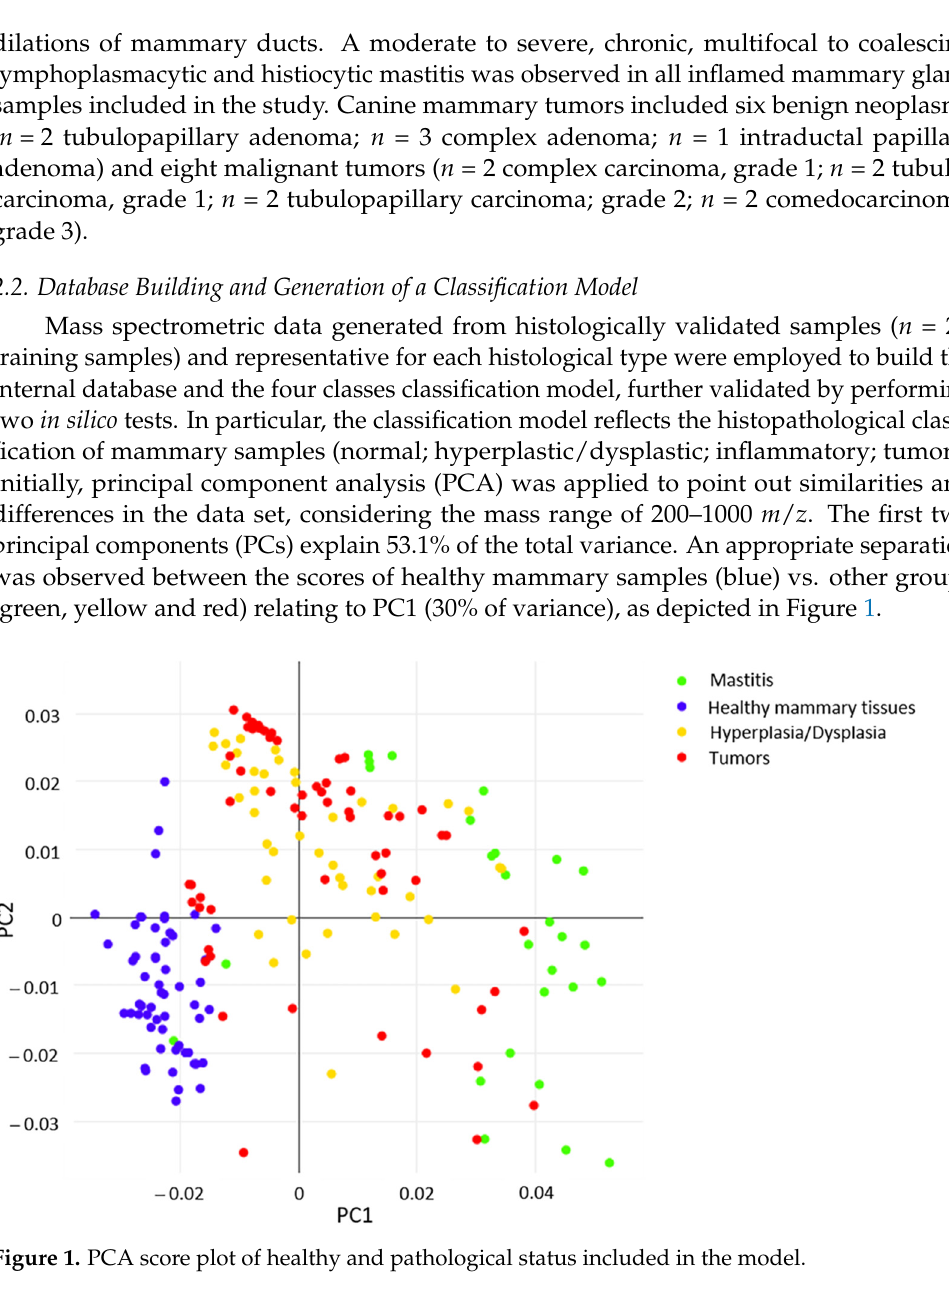
Figure 1. PCA score plot of healthy and pathological status included in the